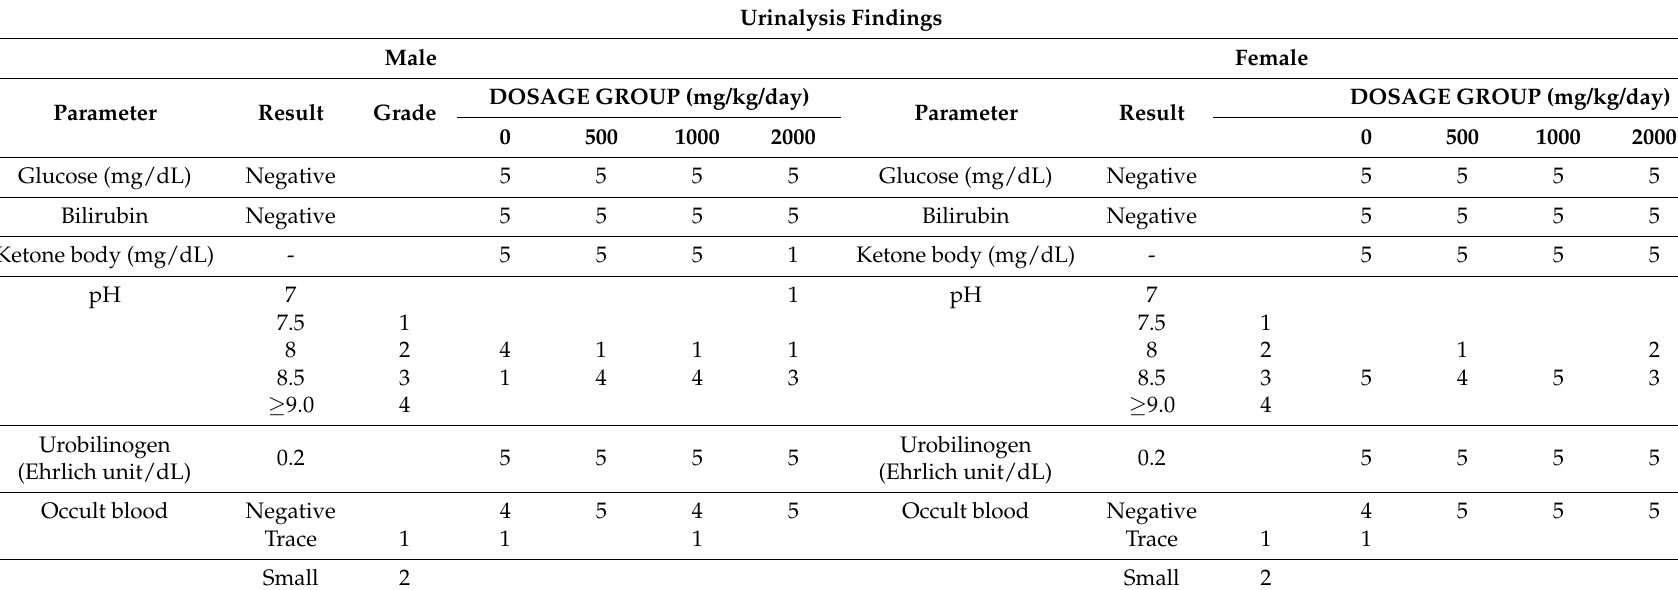
Table 5. Urinalysis findings in male and female rats given 500, 1000, or 2000 mg/kg/day GEE for 14 days in a repeated oral dose toxicity study.